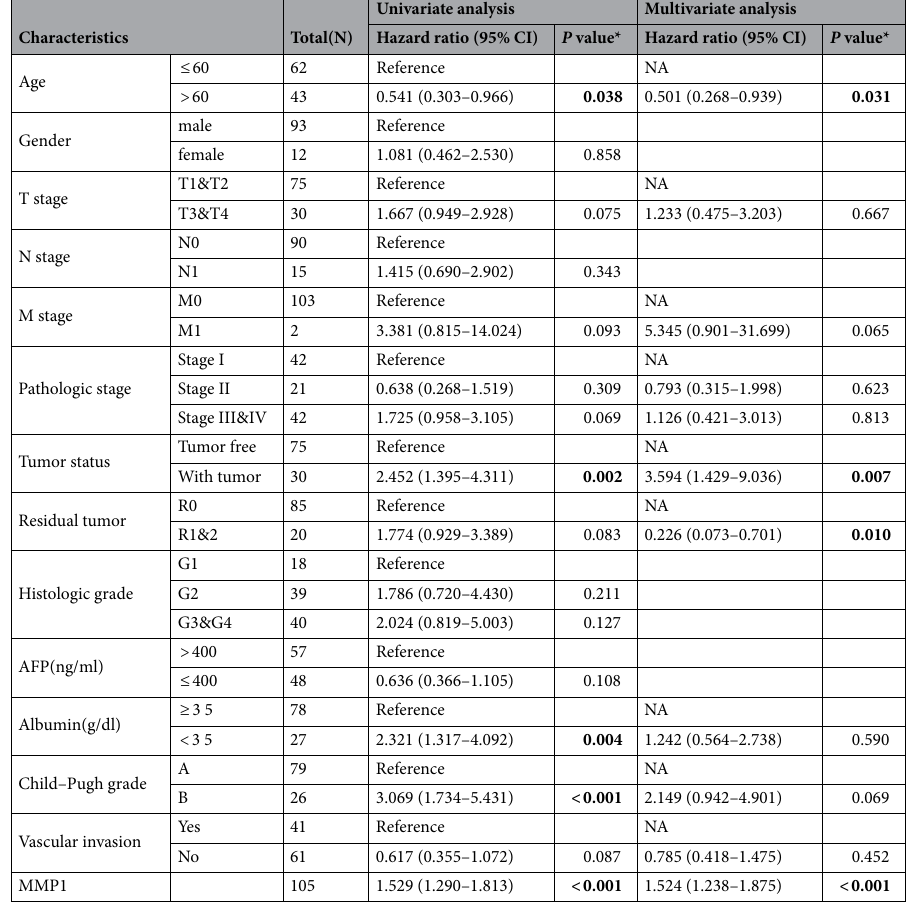
Table 8. The univariate and multivariate analysis for the OS (Clinical HCC). OS overall survival, CI confidence interval, NA reference group or could not be evaluated. *Compared with each group (Log-Rank test or Omnibus test for univariate, Cox regression analysis with adjusted hazard for multivariate). p < 0.05 means statistically significant (highlighted in